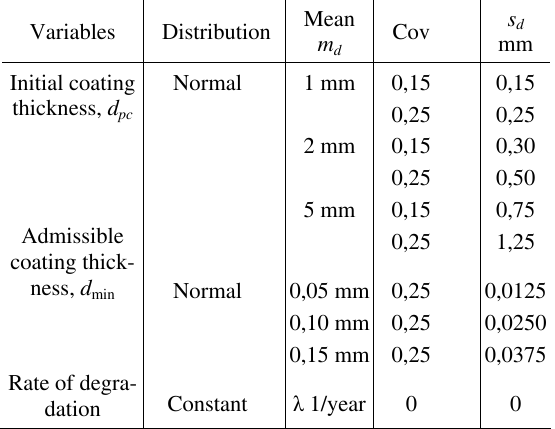
Rate of degra- dation